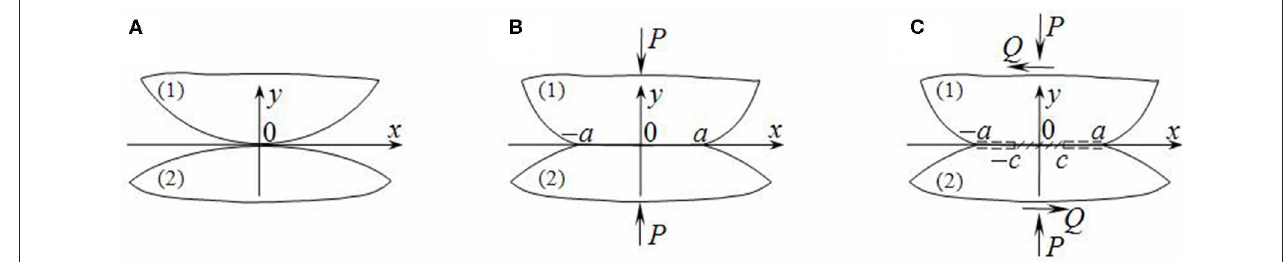
FIGURE 1 | Scheme of contact: (A) bodies prior to loading and (B) the first stage and (C) the second stage of loading.